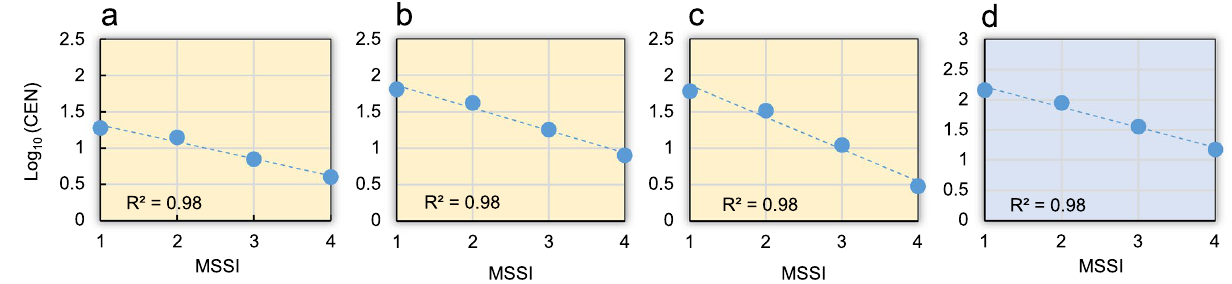
Figure 3. Completeness of reconstructed storms events. Cumulative distribution of the logarithm of the number of storm events versus their Monthly Storm-Severity Index ( MSSI ) in the Tiber River Basin for sub- periods (yellow-coloured graphs) ( a ) Medieval Climate Anomaly: 725–1249 CE; ( b ) Little Ice Age: 1250–1849 CE; ( c ) Current Warm Period 1850–2019 CE; and ( d ) the entire dataset: 725–2019 CE (blue coloured